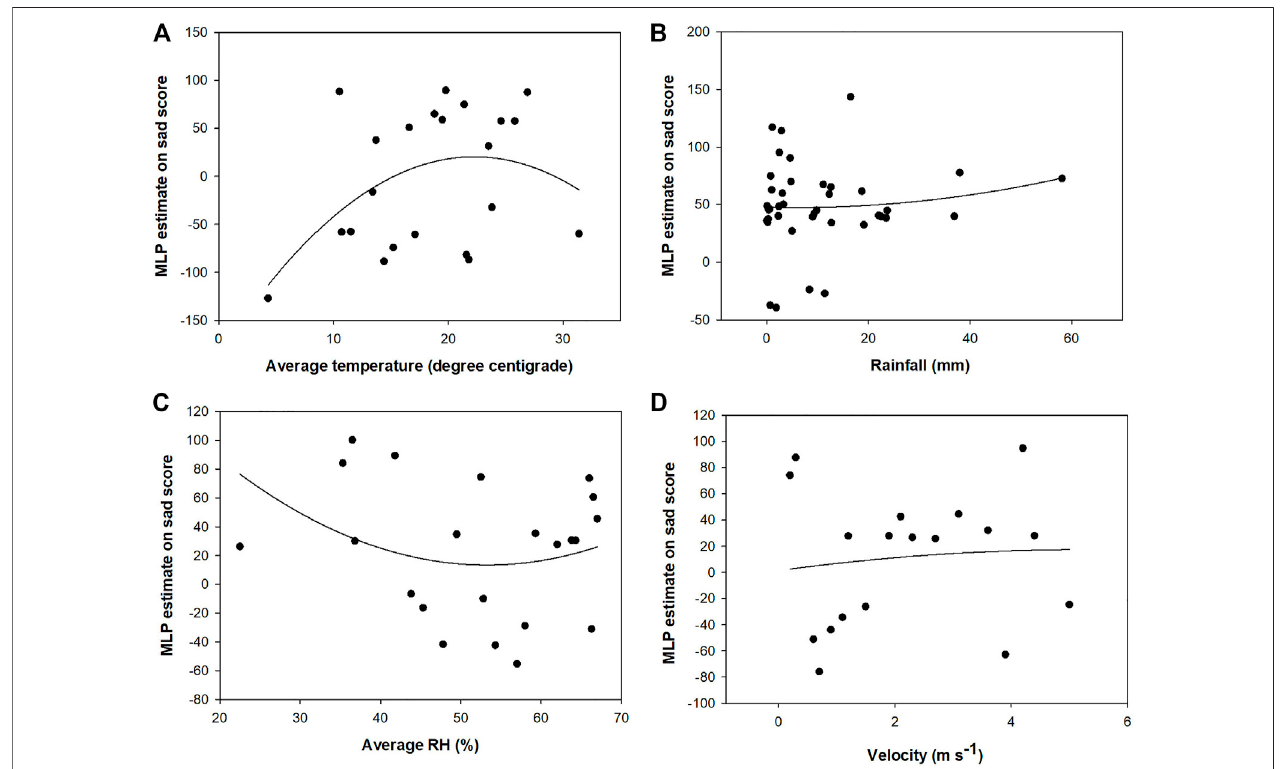
from Supplementary Table S4 . Coef fi cients of regressed models can be found in Table 2